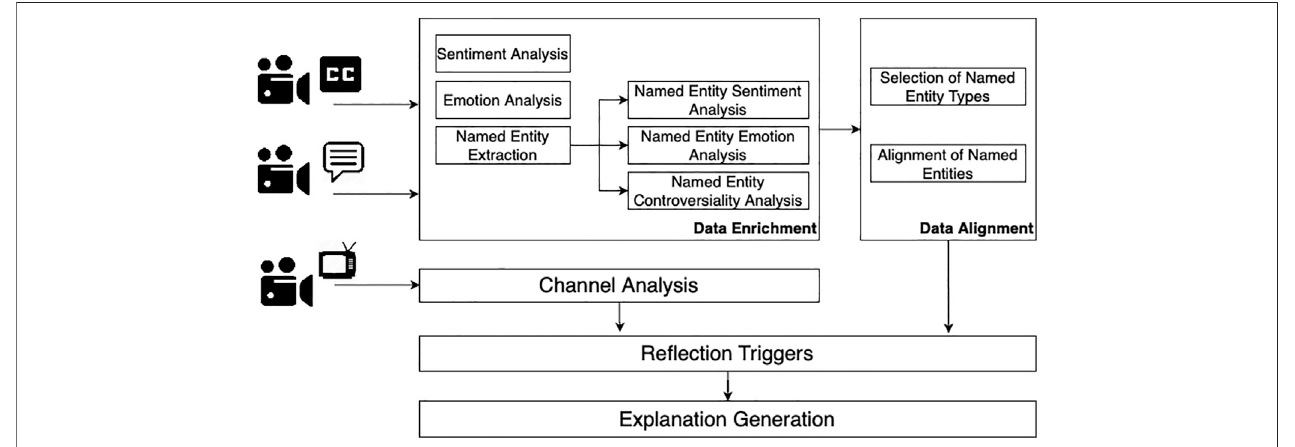
FIGURE 1 | Pipeline for re fl ective assessment of